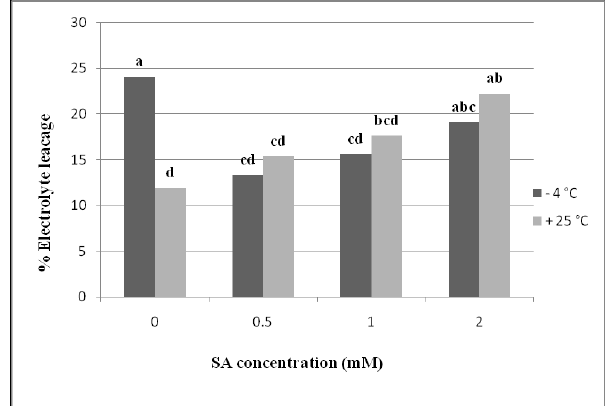
Fig. 3. Effect of exogenous SA pretreatment (0, 0.5, 1 and 2 mM) on relative electrolyte leakage in apricot flower buds under different temperature treatments (-4 and